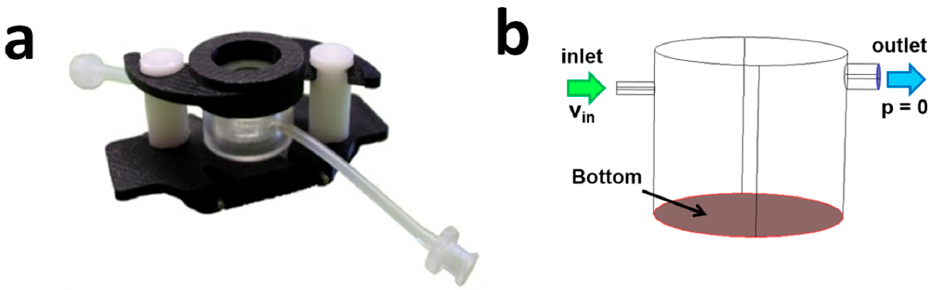
Figure 3. The LB1 bioreactor: ( a ) the transparent chamber and clamps; and ( b ) the inlet and outlet channel and culture region.